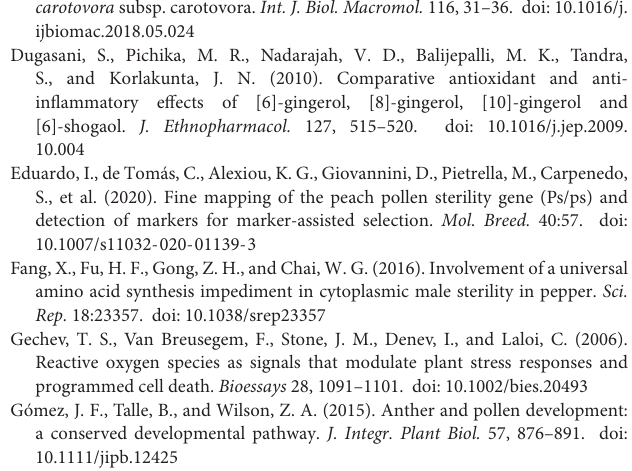
Supplementary Figure 1 | Appearance of flower buds at different developmental stages in “ZH” and “JX.” Bar = 1 cm. Supplementary Figure 2 | The Pearson correlation between samples. B represents “ZH,” and C represents “JX.” Supplementary Figure 3 | The 3D PCA plot between samples. B represents “ZH,” and C represents “JX.” Supplementary Figure 4 | GO classifications of DEGs at S0, S1, and S3. Supplementary Table 1 | The primers used in this article. Supplementary Table 2 | Differentially expressed genes (DEGs) involved in ROS-related pathways and their description. Supplementary Table 3 | Mitochondrial DEGs involved in oxidative phosphorylation and their